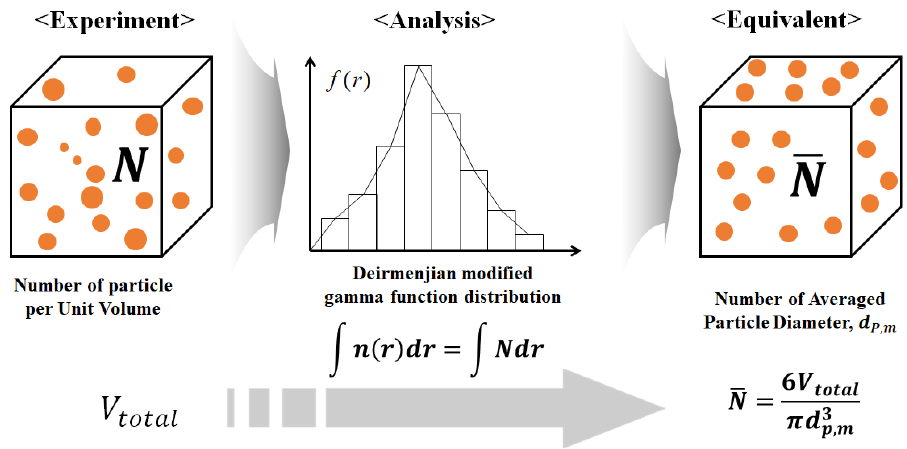
Figure 2. The schematic diagram of the analytic method for distribution of the particles.